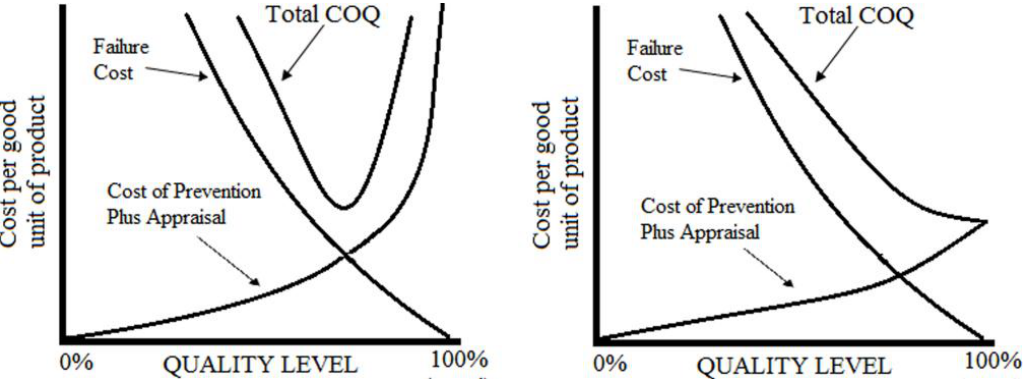
Figure 2. Classical view on the left and the modern view on the right.